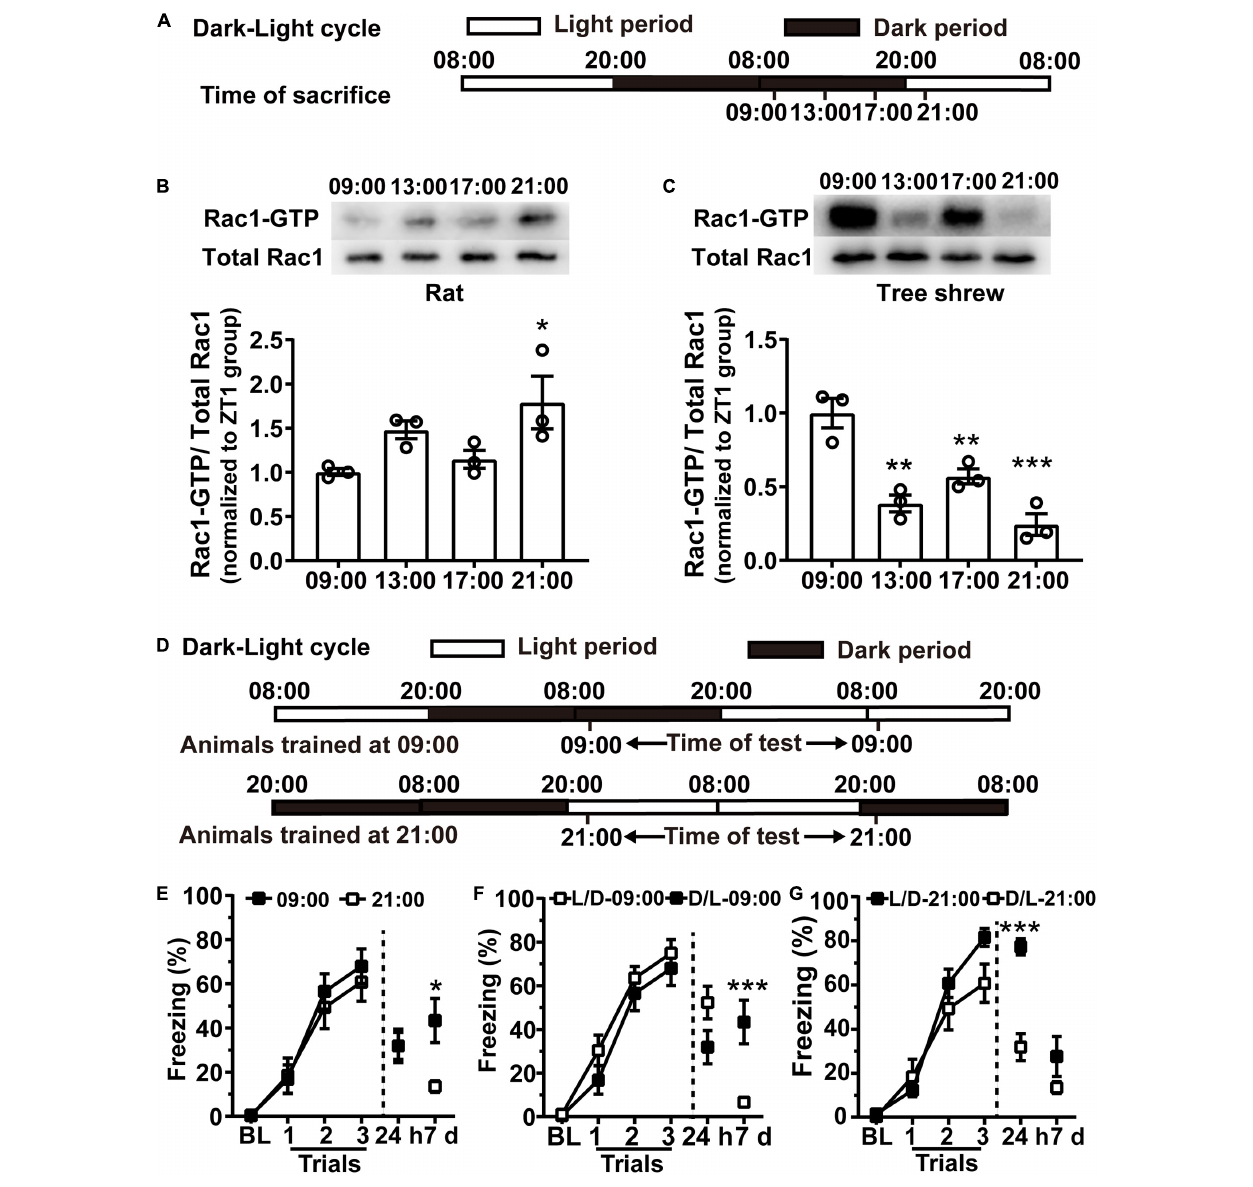
FIGURE 3 | The better contextual fear memory still coincides with the lower Rac1 activation in rats during the night after day and night reversion. (A,D) Diagrams for experimental procedures. (B) Acute light irradiation shifts the hippocampal Rac1 activation cycle in rats. WB demonstrated that Rac1 activity remarkably increased in the 21:00 group compared with the 09:00 group. (C) Acute alteration of light conditions shifts the hippocampal Rac1 activation cycle in tree shrews. WB demonstrated that Rac1 was sharply activated at 09:00 compared with the 21:00 group. (E) The freezing in the 09:00 group was similar to the 21:00 group in 24 h test and significantly higher at 7 days after training under the D/L cycle. L/D represents the light-dark cycle, D/L represents the dark-light cycle. (F) The 09:00 group under D/L cycle presented significantly higher freezing than the 09:00 group under L/D cycle at 7days after learning. (G) The 21:00 group under L/D cycle presented significantly higher freezing than the 21:00 group under D/L cycle at 24 h and 7 days after learning. Data are presented as mean ± SEM. * p < 0.05, ** p < 0.01, *** p <